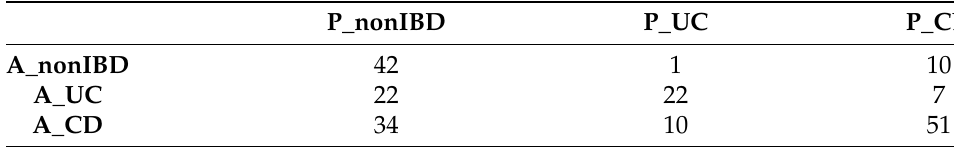
Table 30. M 2 matrix (IBD).